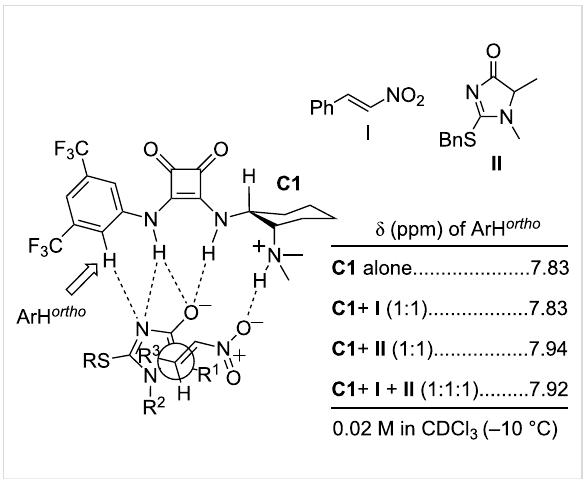
Figure 3: Proposed model for the Michael addition of 1 H -imidazol4- (5 H )-ones and selected 1 H NMR data which support it [55].